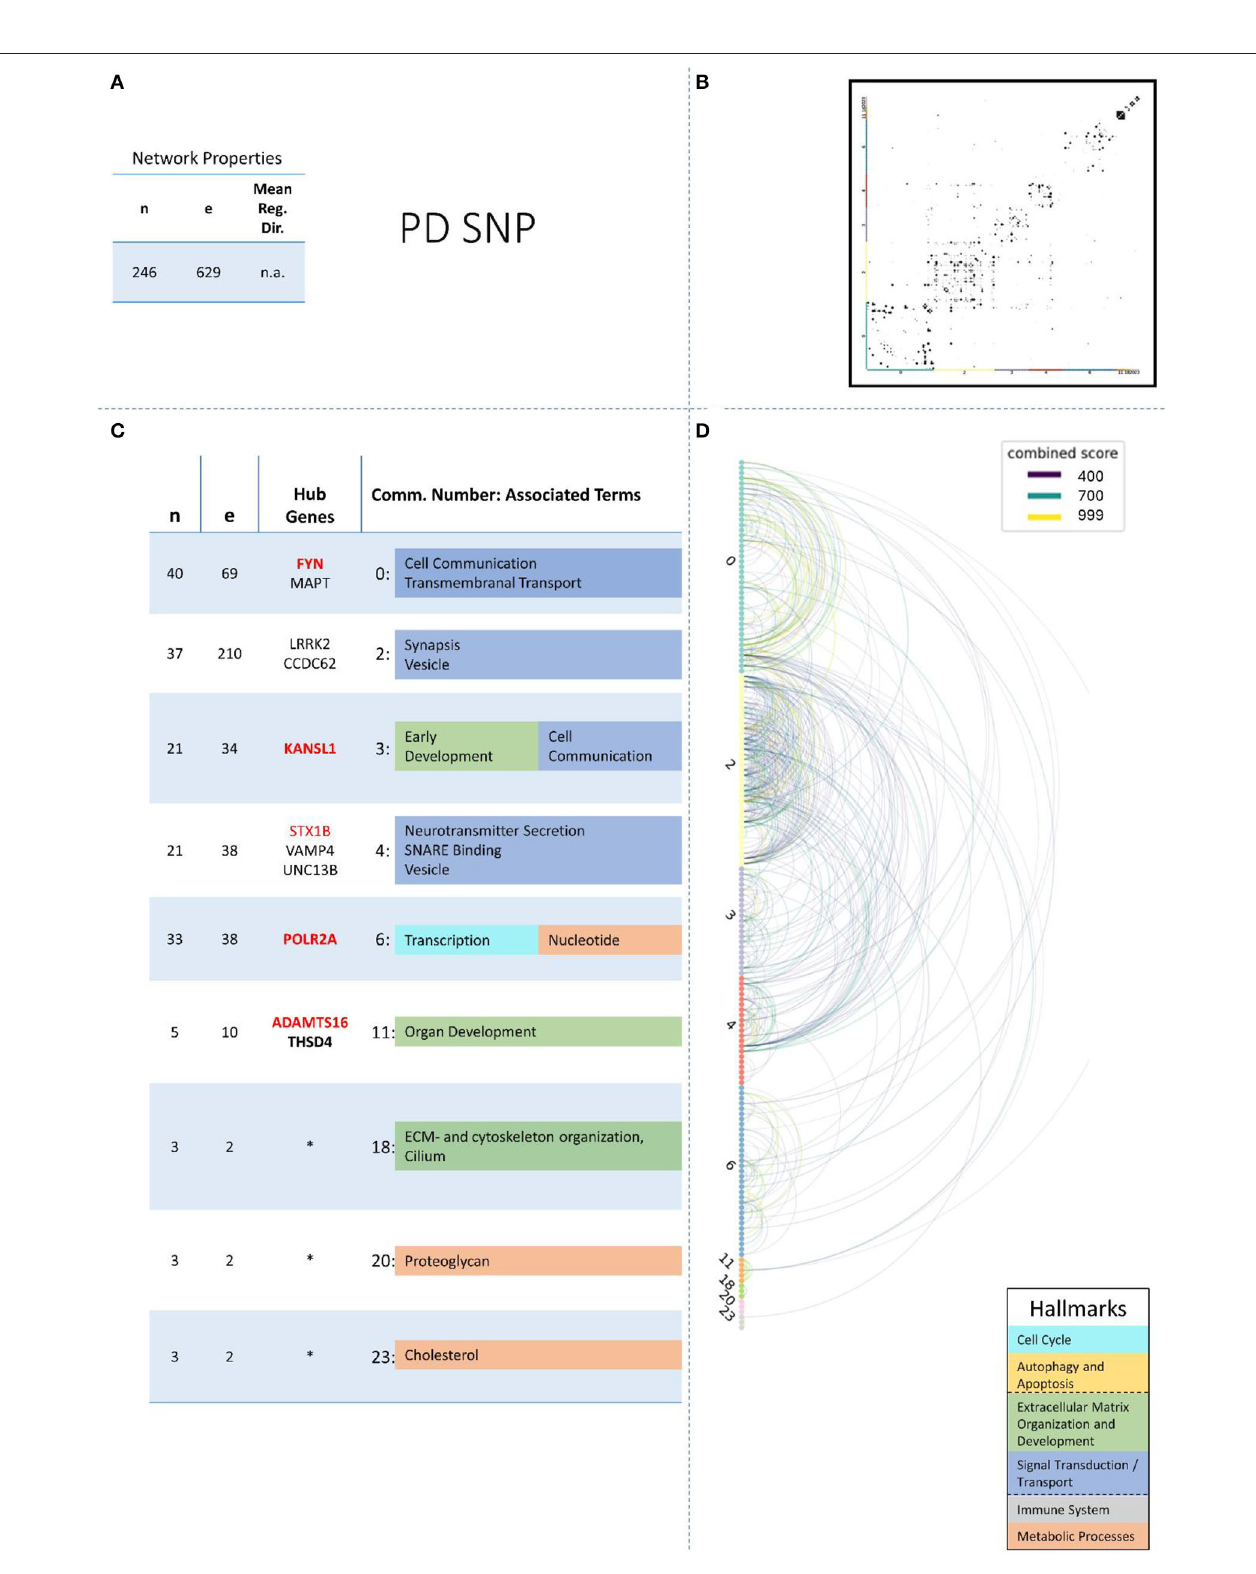
FIGURE 3 | Summarizing figure of the network analysis results of the genomic layer of PD. The general properties, such as number of nodes (genes) and edges (a combined score > 400 between two nodes) of the PPI, network constructed with all PD genomic genes are given in Subfigure (A) . The